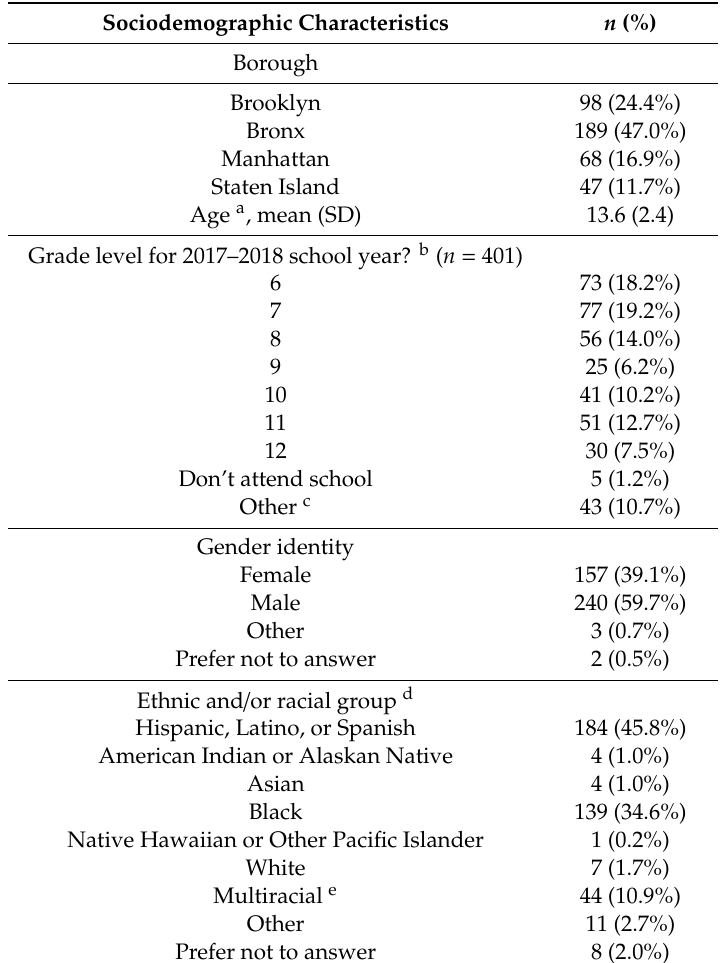
Table 1. Sociodemographic characteristics of surveyed youth who visited a City Harvest Healthy Retail Program corner store during the one-time store visit ( n =